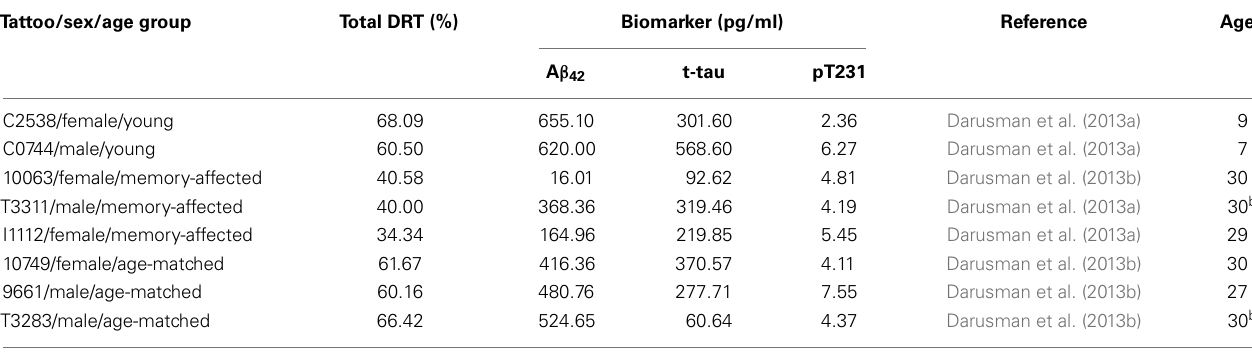
Table 1 |The characteristics of the subjects